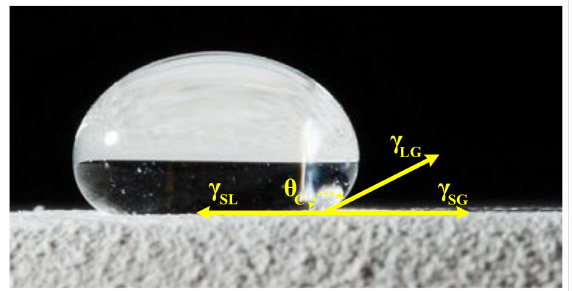
Figure 1. Young’s model of wettability with three vectors of solid–gas, solid–liquid and liquid–vapor surface